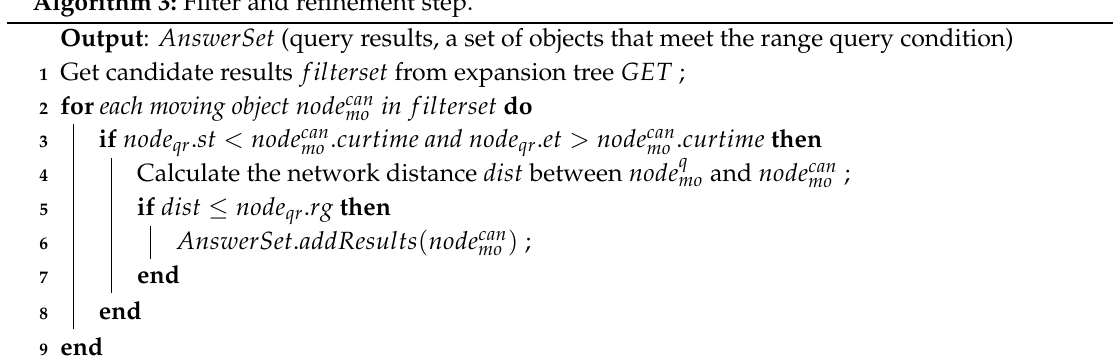
Algorithm 3: Filter and refinement